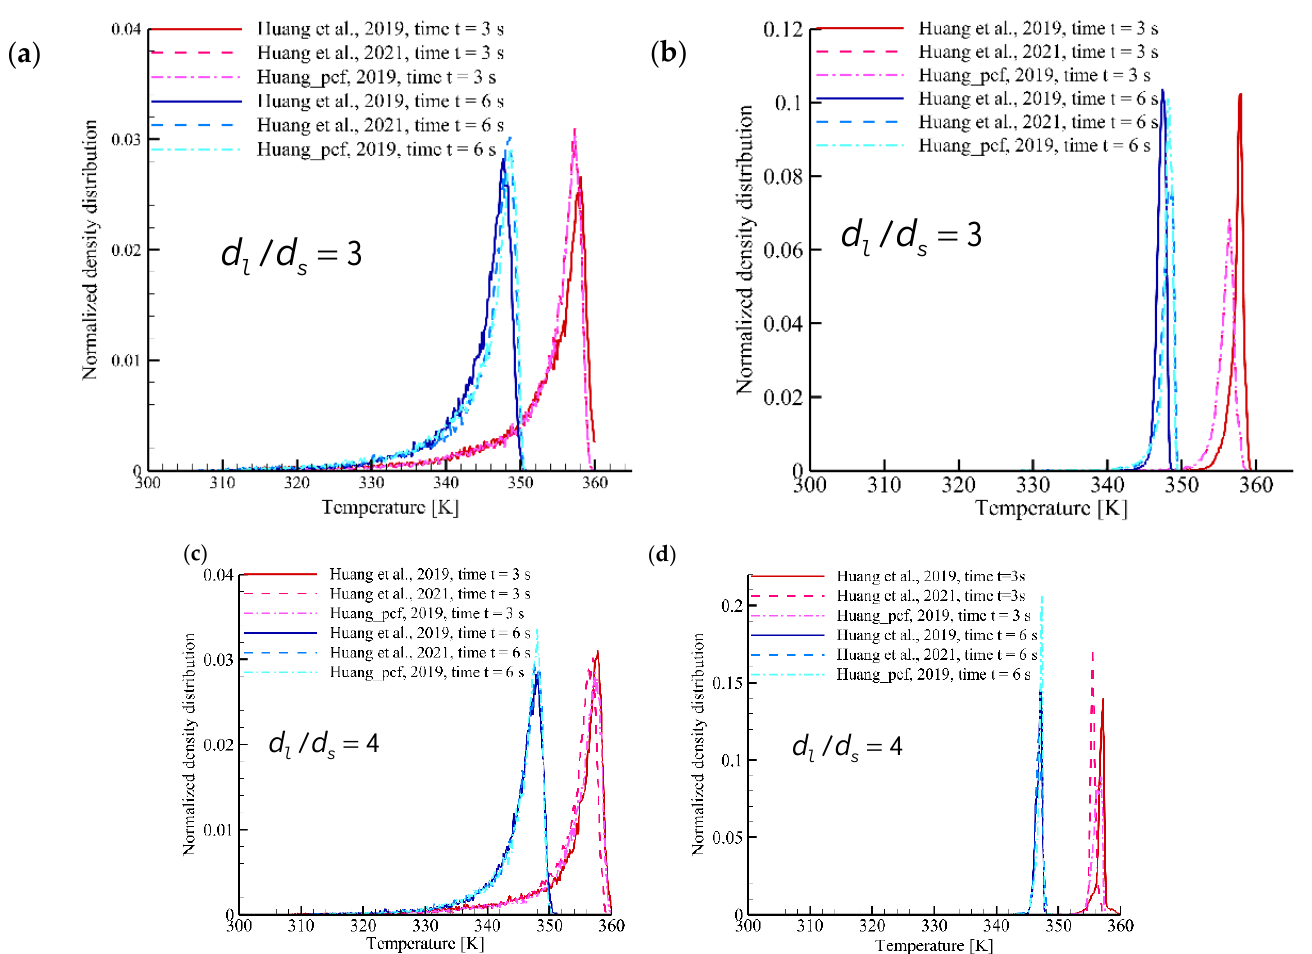
Figure 9. Particle temperature distribution profile: ( a , c ) large particles; ( b , d ) small particles. Huang et al., 2019 [9], Huang et al., 2021